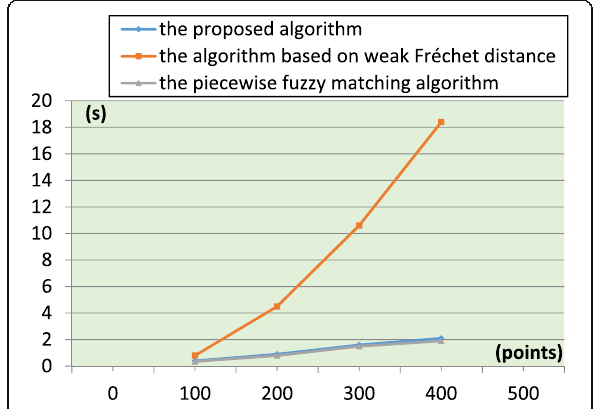
Fig. 12 Running time of different algorithms